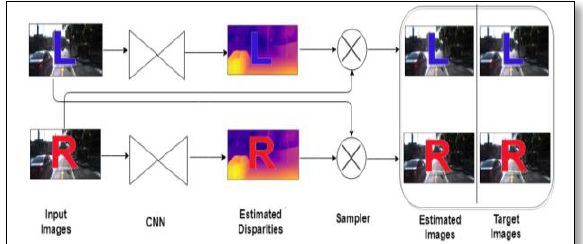
Figure 3. Dual CNN with 6 losses. Adapted from “Dual CNN Models for Unsupervised Monocular Depth Estimation”, by Repala, V. K., & Dubey, S. R. (2018).,